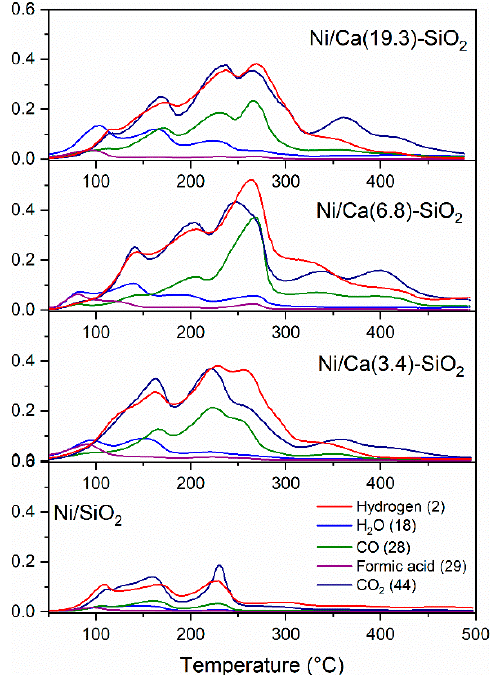
Figure 9. Temperature-programmed surface-reaction profiles of Ni catalysts after 40 Torr pulse of HCOOH at 40 °C.